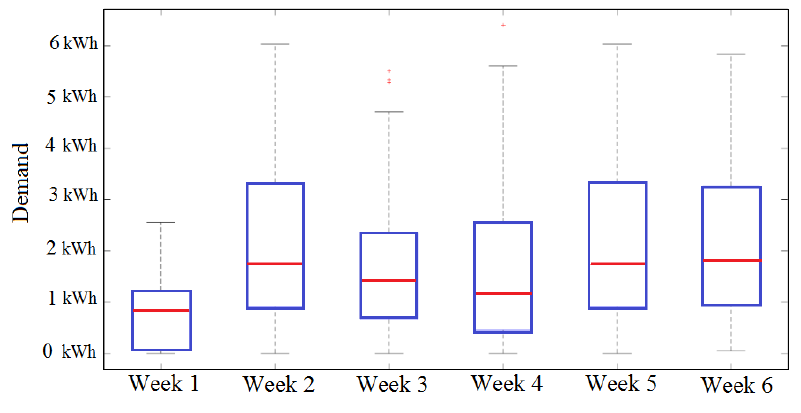
Figure 12. Box plot of hourly household demand over six weeks starting from 1 January 2019.